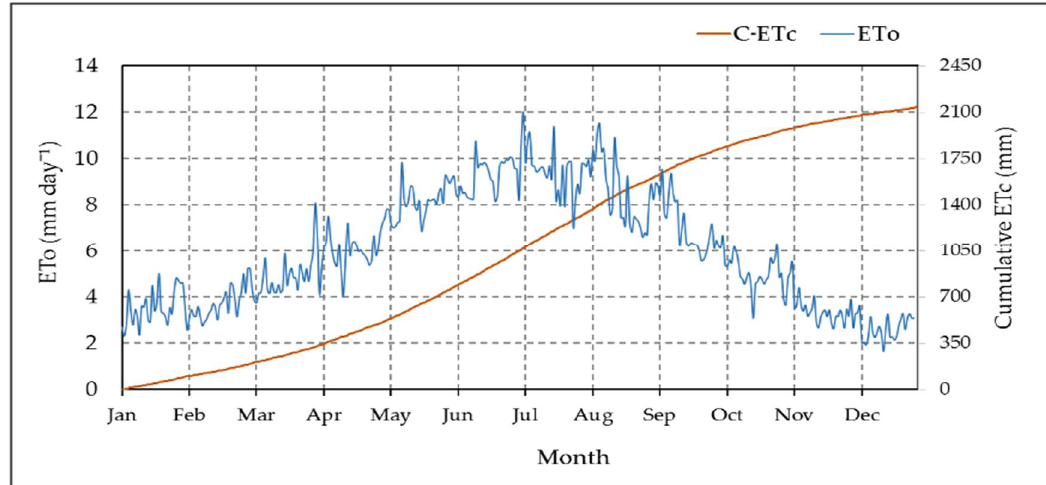
Figure 14. The calculated reference evapotranspiration (ETo) and the cumulative crop evapotranspiration (C-ETc) over the year 2020 in the experimental site.